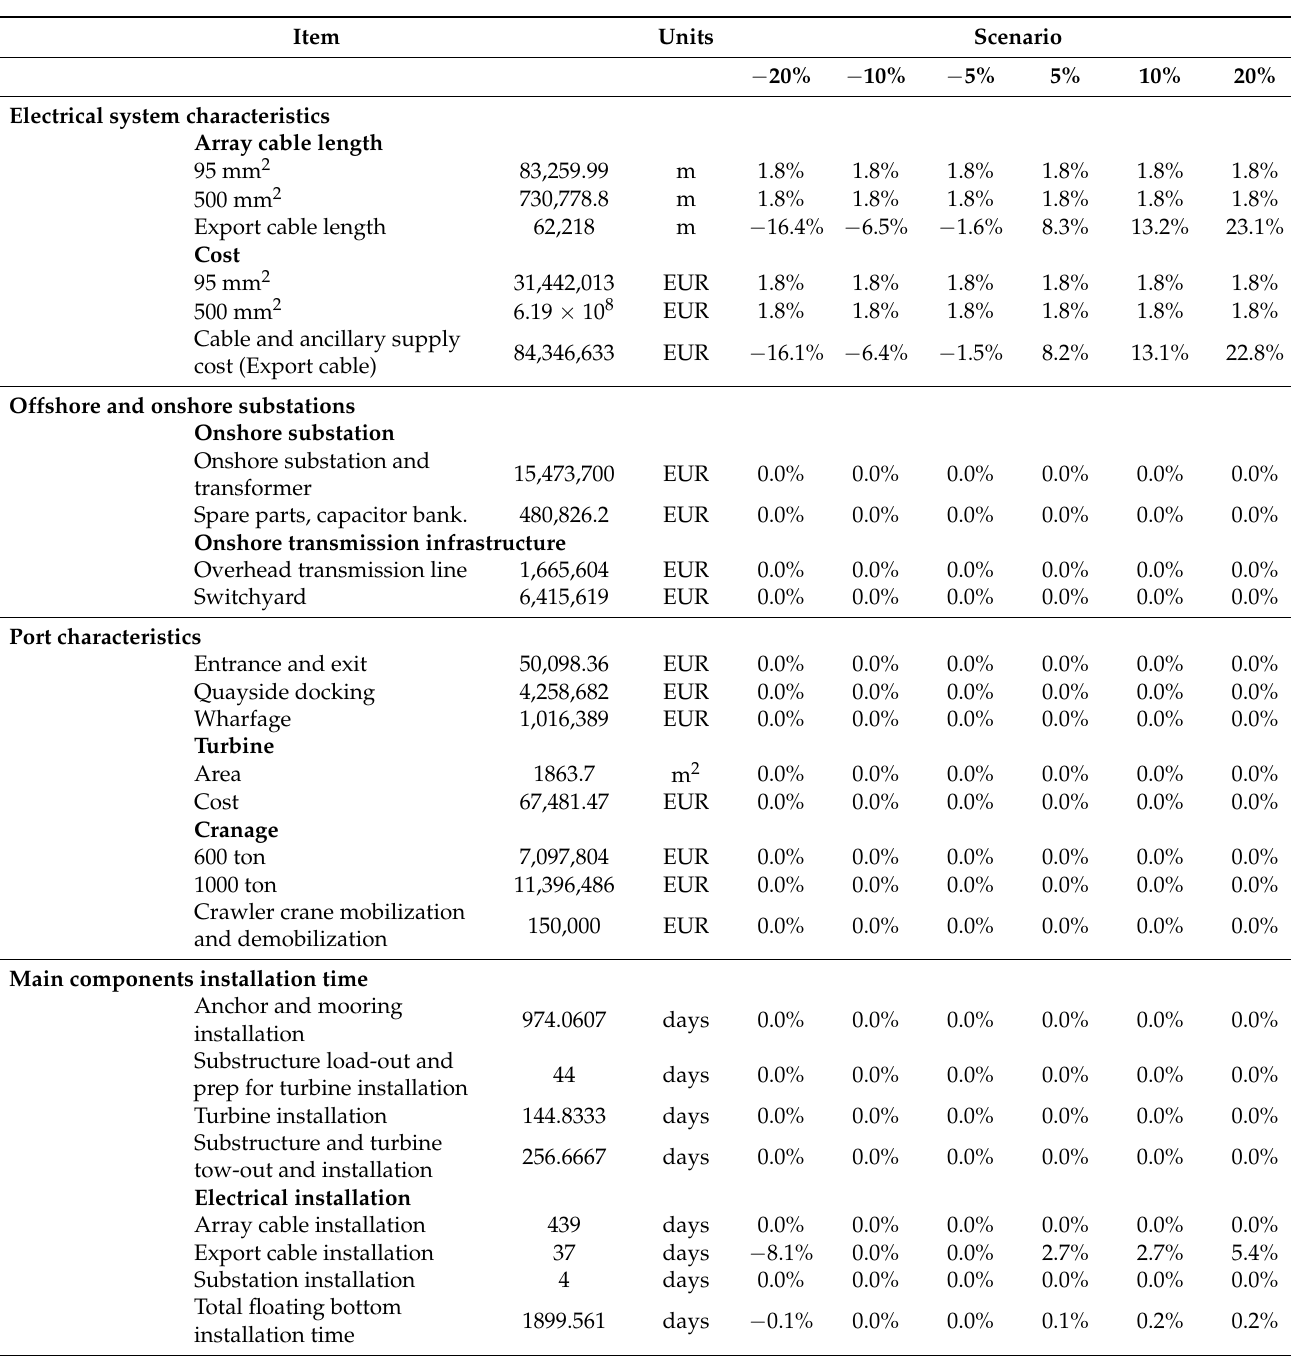
Table A3. Variability associated with the distance to the electrical